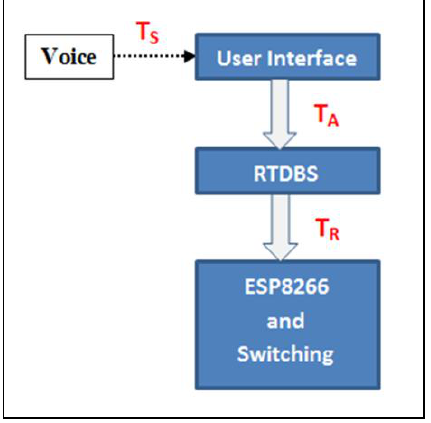
Figure 5. Total Response